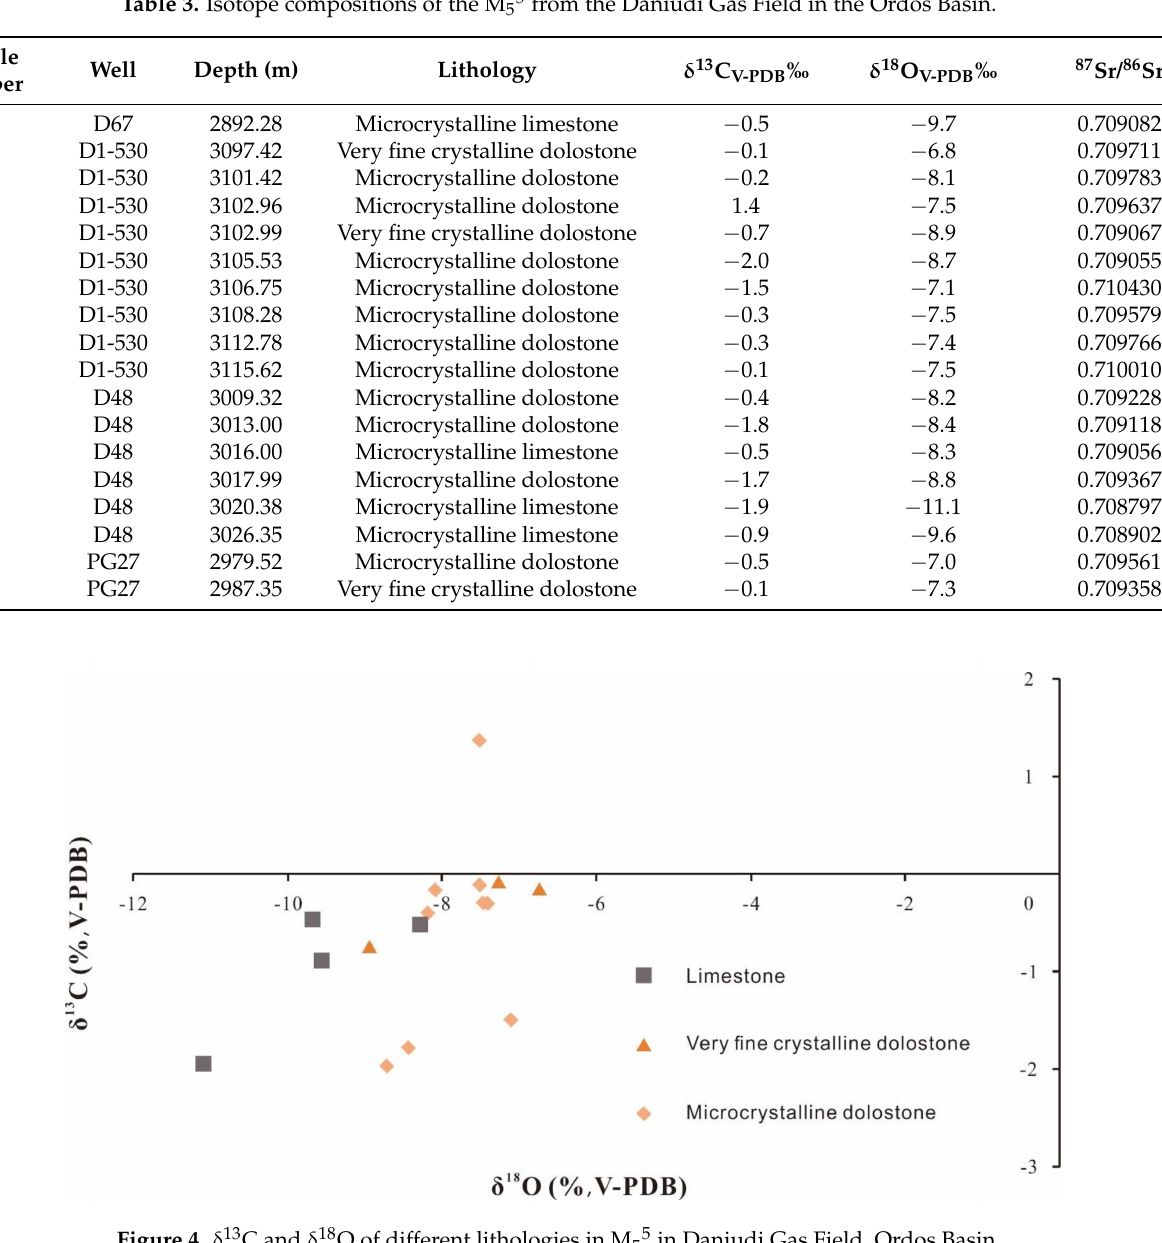
Table 3. By comparing the results of this experiment with the isotope values of Ordovician seawater, the δ 18 O values in the study area were all negative, and the δ 13 C values were similar to the seawater values of the same period. The isotopic characteristics of different lithologies were different to a certain extent. The δ 13 C values of limestone samples were between –0.46‰ and − 1.94‰, with an average value of − 0.95‰, and the δ 18 O values were between − 8.29‰ and − 11.1‰, and the average value was − 9.66‰, with a large negative bias. The δ 13 C values of microcrystalline dolostone were between 1.38‰ and − 1.96‰, with an average value of − 0.66‰, and the δ 18 O values were between − 7.01‰ and − 8.72‰, and the average value was − 7.84‰. The δ 13 C values of the very fine crystalline dolostone were between − 0.06‰ and − 0.72‰, with an average value of − 0.3%. The δ 18 O values of the very fine crystalline dolostone were between − 6.75‰ and − 8.93‰, and the average value was − 7.65%. The δ 13 C and δ 18 O characteristics of different lithologies are shown in Figure 4. Table 3. Isotope compositions of the M 55 from the Daniudi Gas Field in the Ordos Basin.